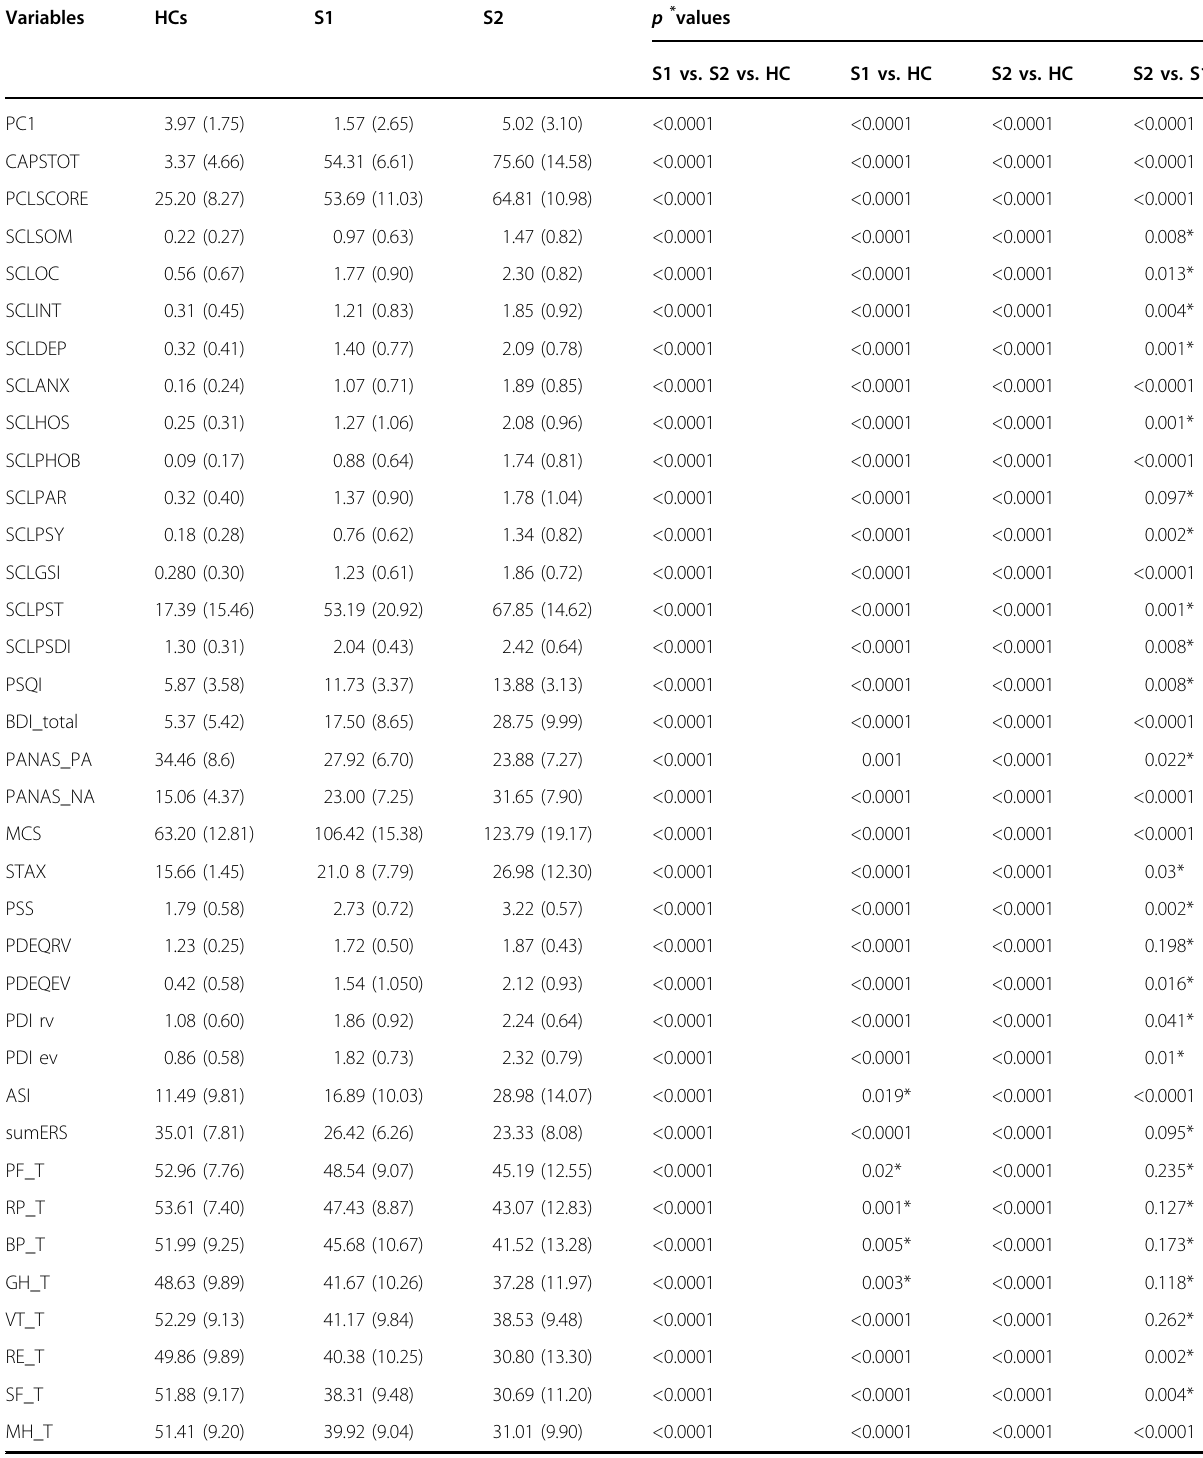
Table 2 Clinical assessments of HCs, S1, S2: ANOVAs and t -test comparisons of mean (sd) scores for total and subscale scores and for principal component 1 of a multiscale PCA